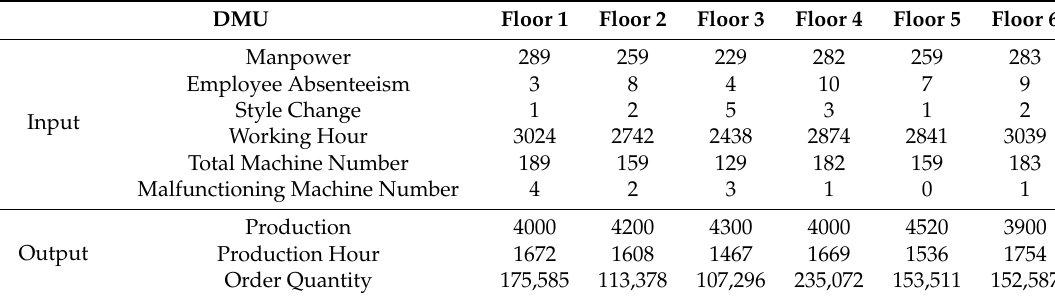
Table 3. Data from the DMUs.